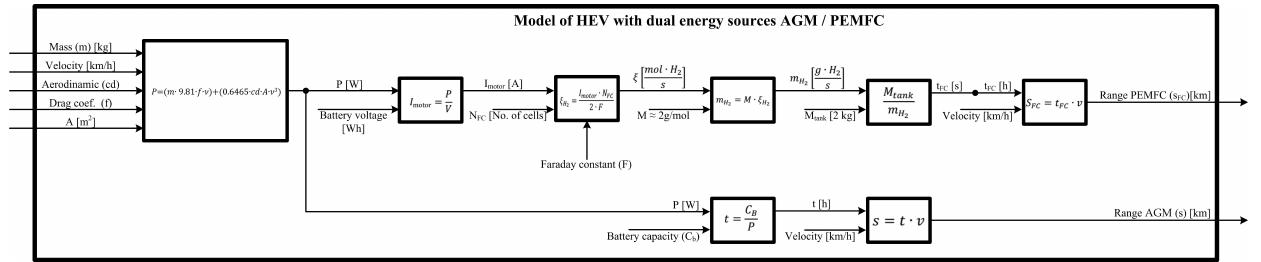
Figure 3. Model of HEV with two energy sources (AGM/PEMFC).